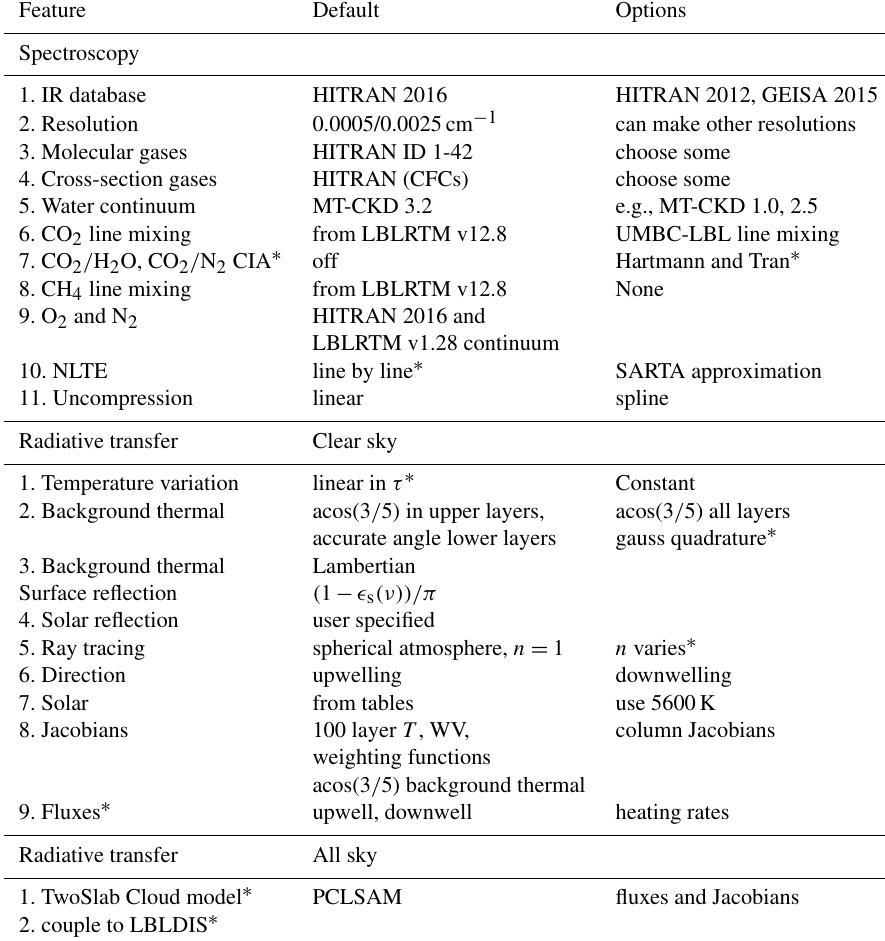
Table B2. kCARTA